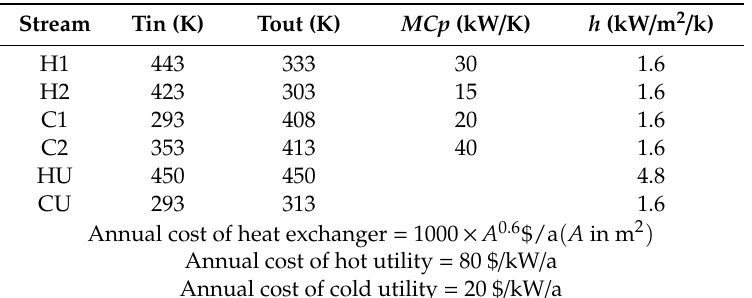
Table 1. Stream, cost, and parameters of case 1.